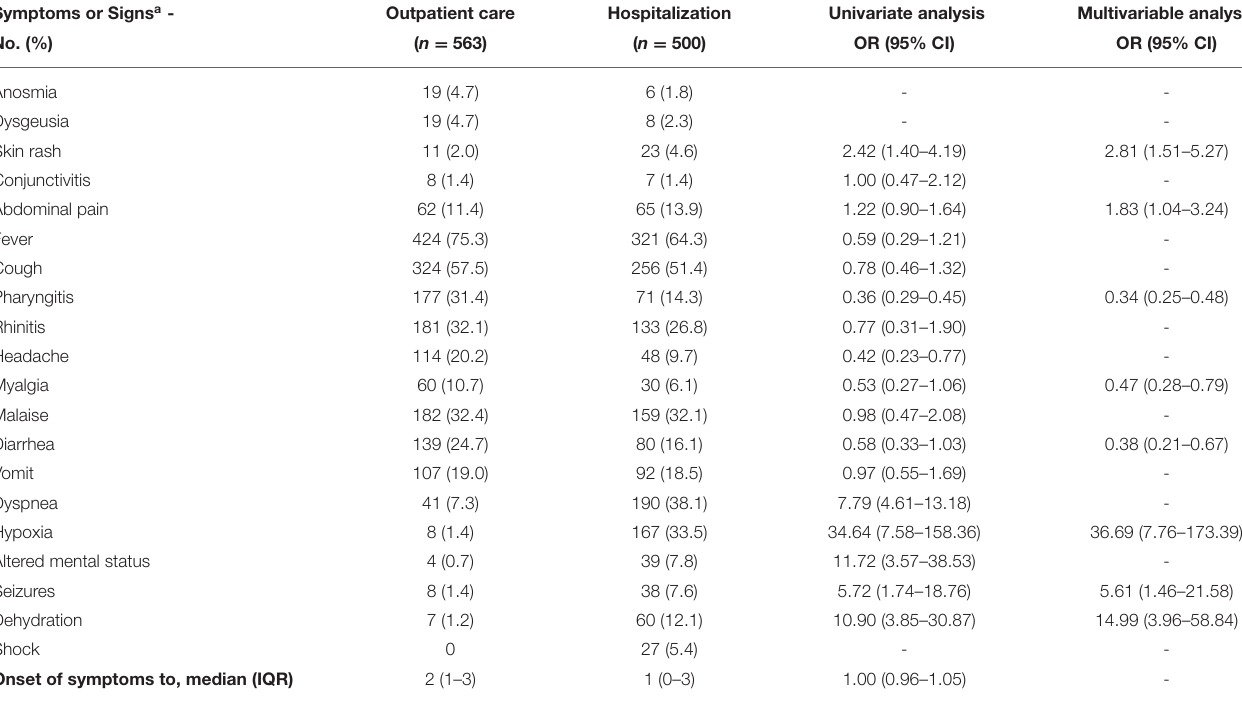
TABLE 3 | Signs or symptoms described or present on initial evaluation associated with hospitalization (general ward and intensive care), among pediatric patients with COVID-19 using multiple imputation chained equations for missing